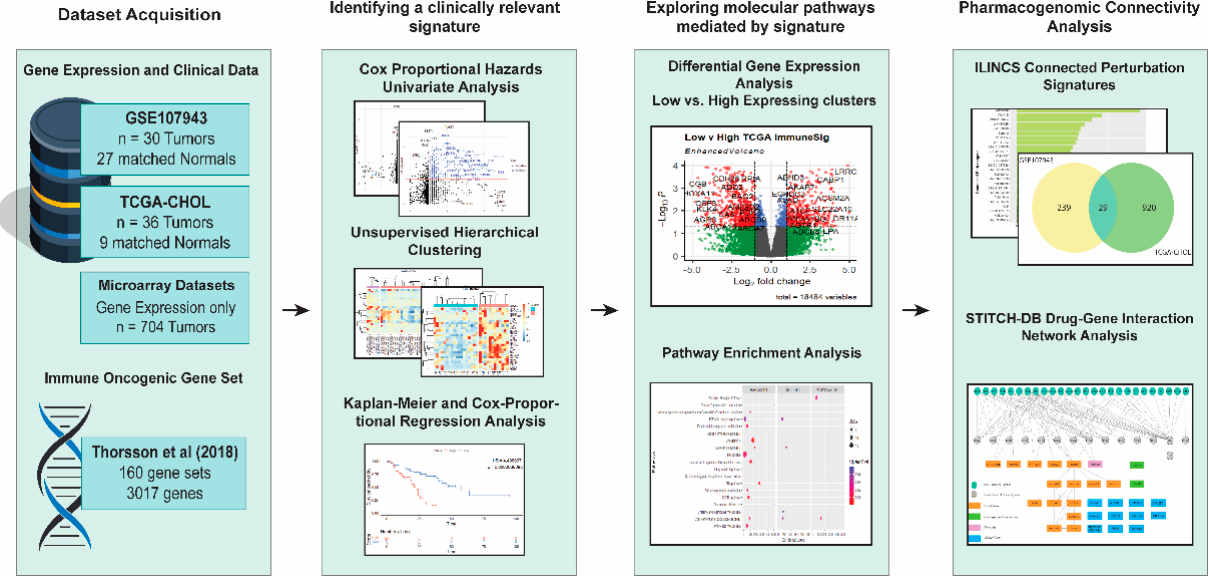
Figure 1. Schematic workflow of the present study. Vectors designed by FreePik (accessed on 30 August 2021).